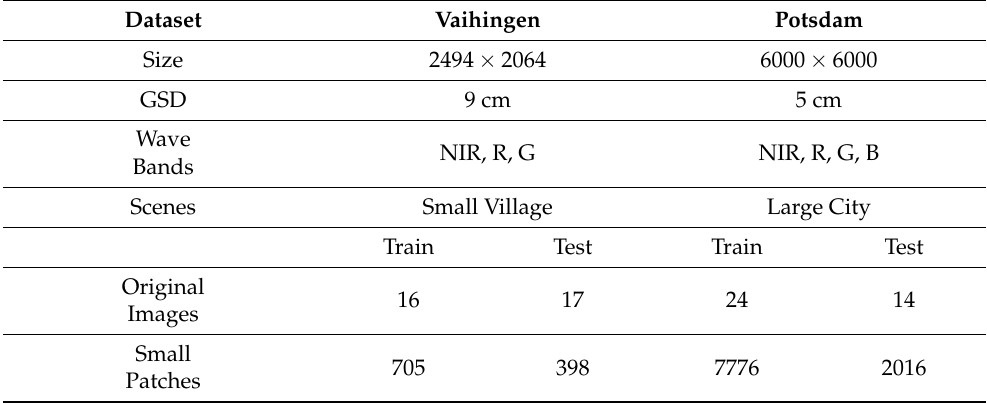
Table 1. The ISPRS datasets used in this paper.